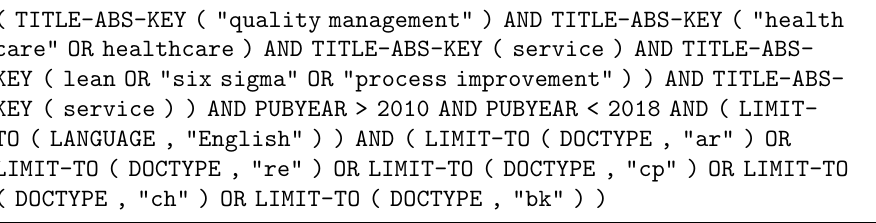
Figure 7. Selection criteria for cluster 5 from the Scopus